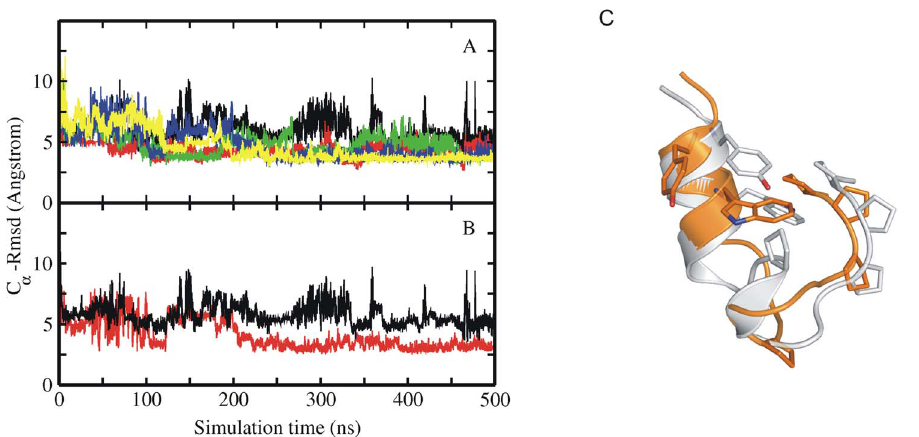
Figure 2. MD simulations of extended Trp-cage structure. (A) RMSD C a of sampled conformations during five cMD simulations with different atomic velocities starting from an extended Trp-cage structure (A). Simulation results in A were obtained using the ff03 force field. (B) Comparison of the RMSD C a of sampled structures for one simulation with respect to a partially unfolded conformation (red curve) and with respect to the native Trp- cage (black curve). The partially unfolded conformation was obtained in simulations starting from the native Trp-cage structure and contains a partially dissociated C-terminal segment (see Figure 2C). (C) Example snapshot of a collapsed structure (orange Cartoon) that came close to within 2.5 A˚ RMSD C a with respect to the partially unfolded structure (grey Cartoon in C). Residues important for folding (Tyr3, Trp6, Pro12, Pro17, Pro18 and Pro19) are shown as sticks.